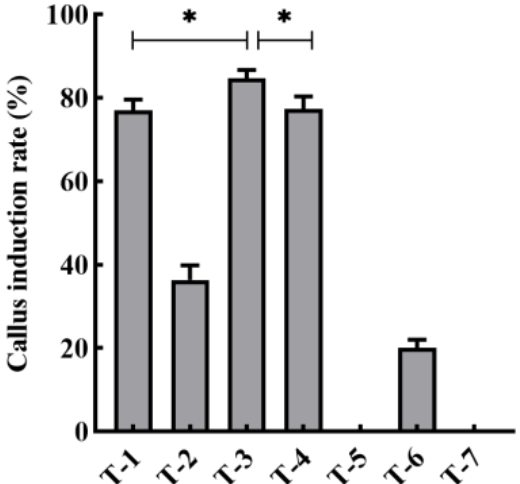
Figure 2. Effect of different mediums and phytohormones on callus induction. T-1 to T-6 denote different methods. The statistical analysis was performed via one-way ANOVA test. Asterisk (*) represents significant difference and corresponds to p < 0.05.